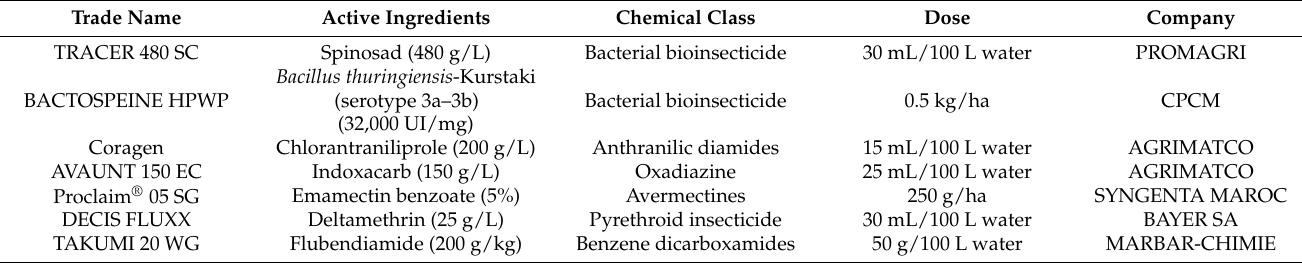
Table 1. Characteristics of the contact insecticides used to control the chickpea pod borer and their respective